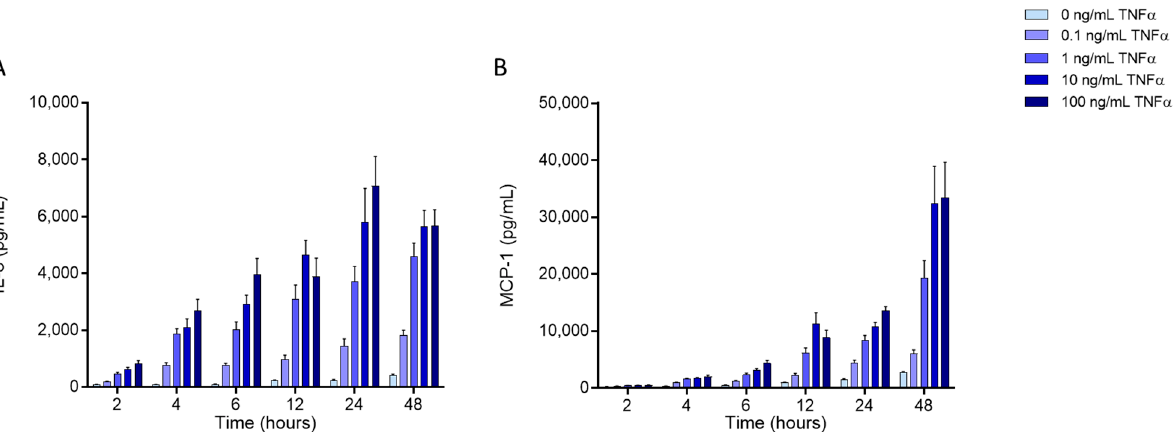
Figure 8. Efect of stimulation of EA.hy926 cells with different concentrations of tumour necrosis factor (TNF)- α on concentrations of interleukin-8 (IL-8; ( A )) and monocyte chemoattractant protein-1 (MCP-1; ( B )) in the culture medium. EA.hy926 cells were cultured with different concentrations of TNF- α (0.1 to 100 ng/mL) for different times (2, 4, 6, 12, 24, 48 h). Concentrations of IL-8 and MCP-1 were measured by ELISA (see Section 4.5). Bars are mean ± SD of 3